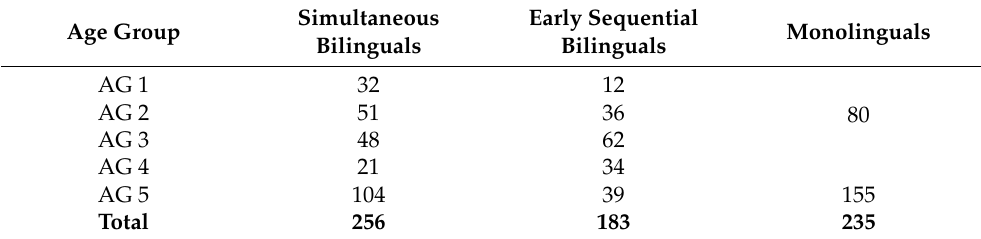
Table 4. Number of target structures in the elicited oral narratives of mono- and bilinguals. Simultaneous Early Age Group Bilinguals